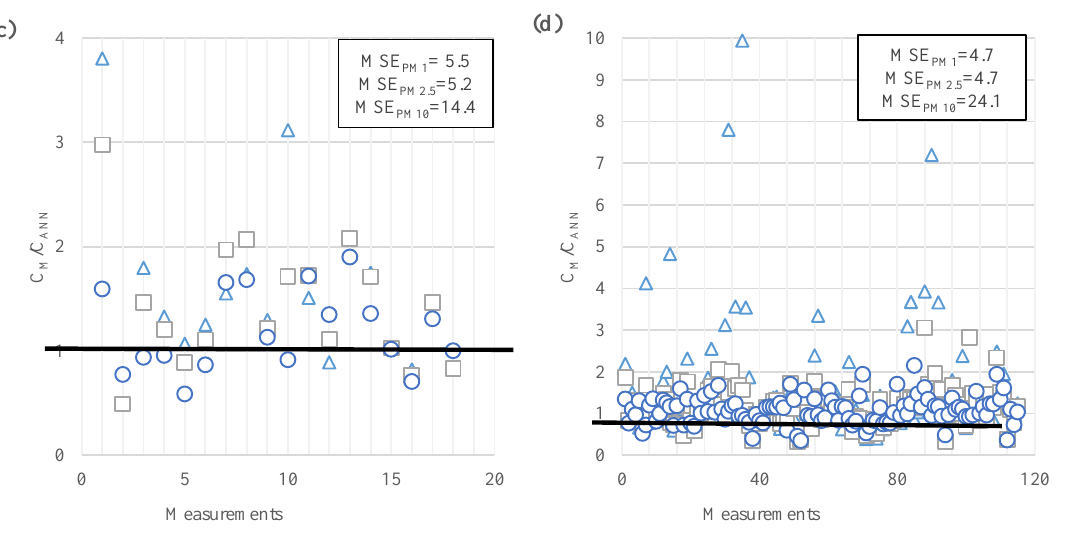
Figure 4. Comparison of measured and calculated concentrations: ( a ) RoRo ships, ( b ) general cargo ships, ( c ) bulk carriers, ( d ) tugs.